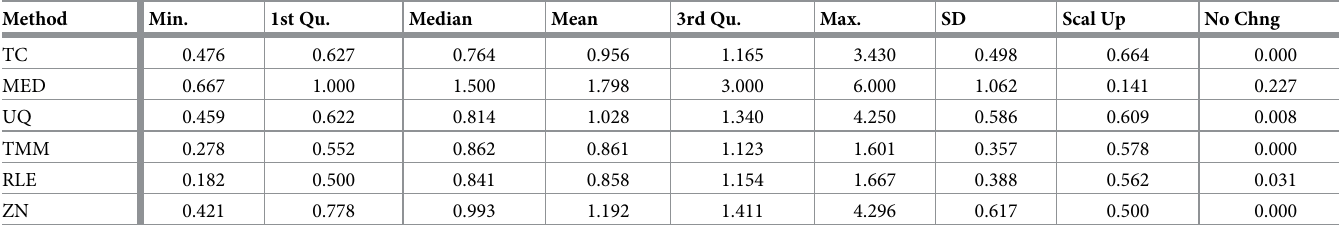
Table 2. Comparisons of estimates of normalizing parameter.